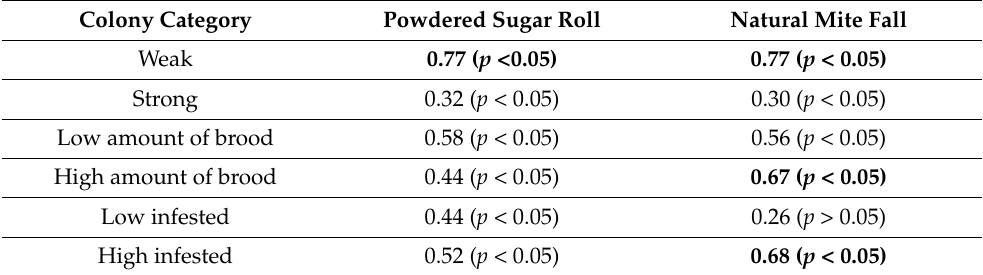
Table 5. Spearman correlation between colonies classified according to strength, amount of brood and infestation class, and total infestation level obtained using different methods. Protocol 2. Colony Category Powdered Sugar Roll Natural Mite